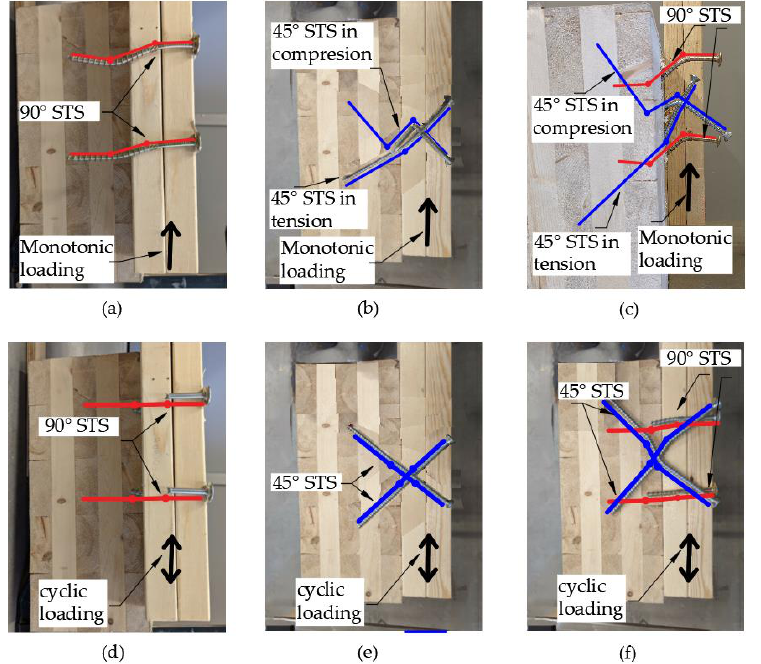
Figure 7. Failure modes of STSs in CLT-lumber connections: ( a ) 90 ° STS; ( b ) 45 ° STS ; ( c ) mixed angle STS (45 ° and 90 °) ; ( d ) STS at 90 ° ; ( e ) STS at 45 ° ; and ( f ) STS at mixed angles (90 ° and 45 ° ).